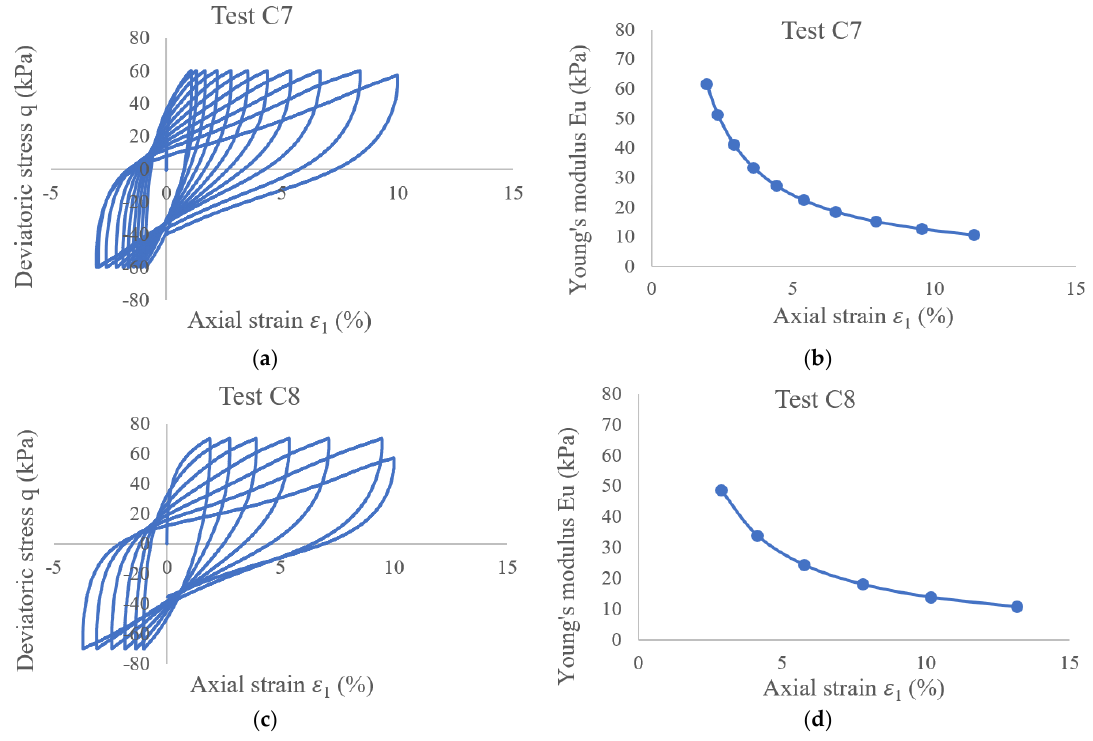
Figure 2. Deviatoric stress and undrained Young’s module vs. axial strain: ( a , b ) test C7 with 𝒑 𝟎 = 𝟐𝟎𝟎 kPa , 𝒒 𝒂𝒎𝒑𝒍 = 𝟔𝟎 kPa , 𝒆 = 𝟏. 𝟐𝟎𝟐 ; ( c , d ) test C8 with 𝒑 𝟎 = 𝟐𝟎𝟎 kPa , 𝒒 𝒂𝒎𝒑𝒍 = 𝟕𝟎 kPa , 𝒆 = p 0 = 200 kPa, q ampl = 60 kPa, e = 1.202; ( c , d ) test C8 with p 0 = 200 kPa, q ampl = 70 kPa, e = 1.202 𝟏. 𝟏𝟐𝟏 [33].